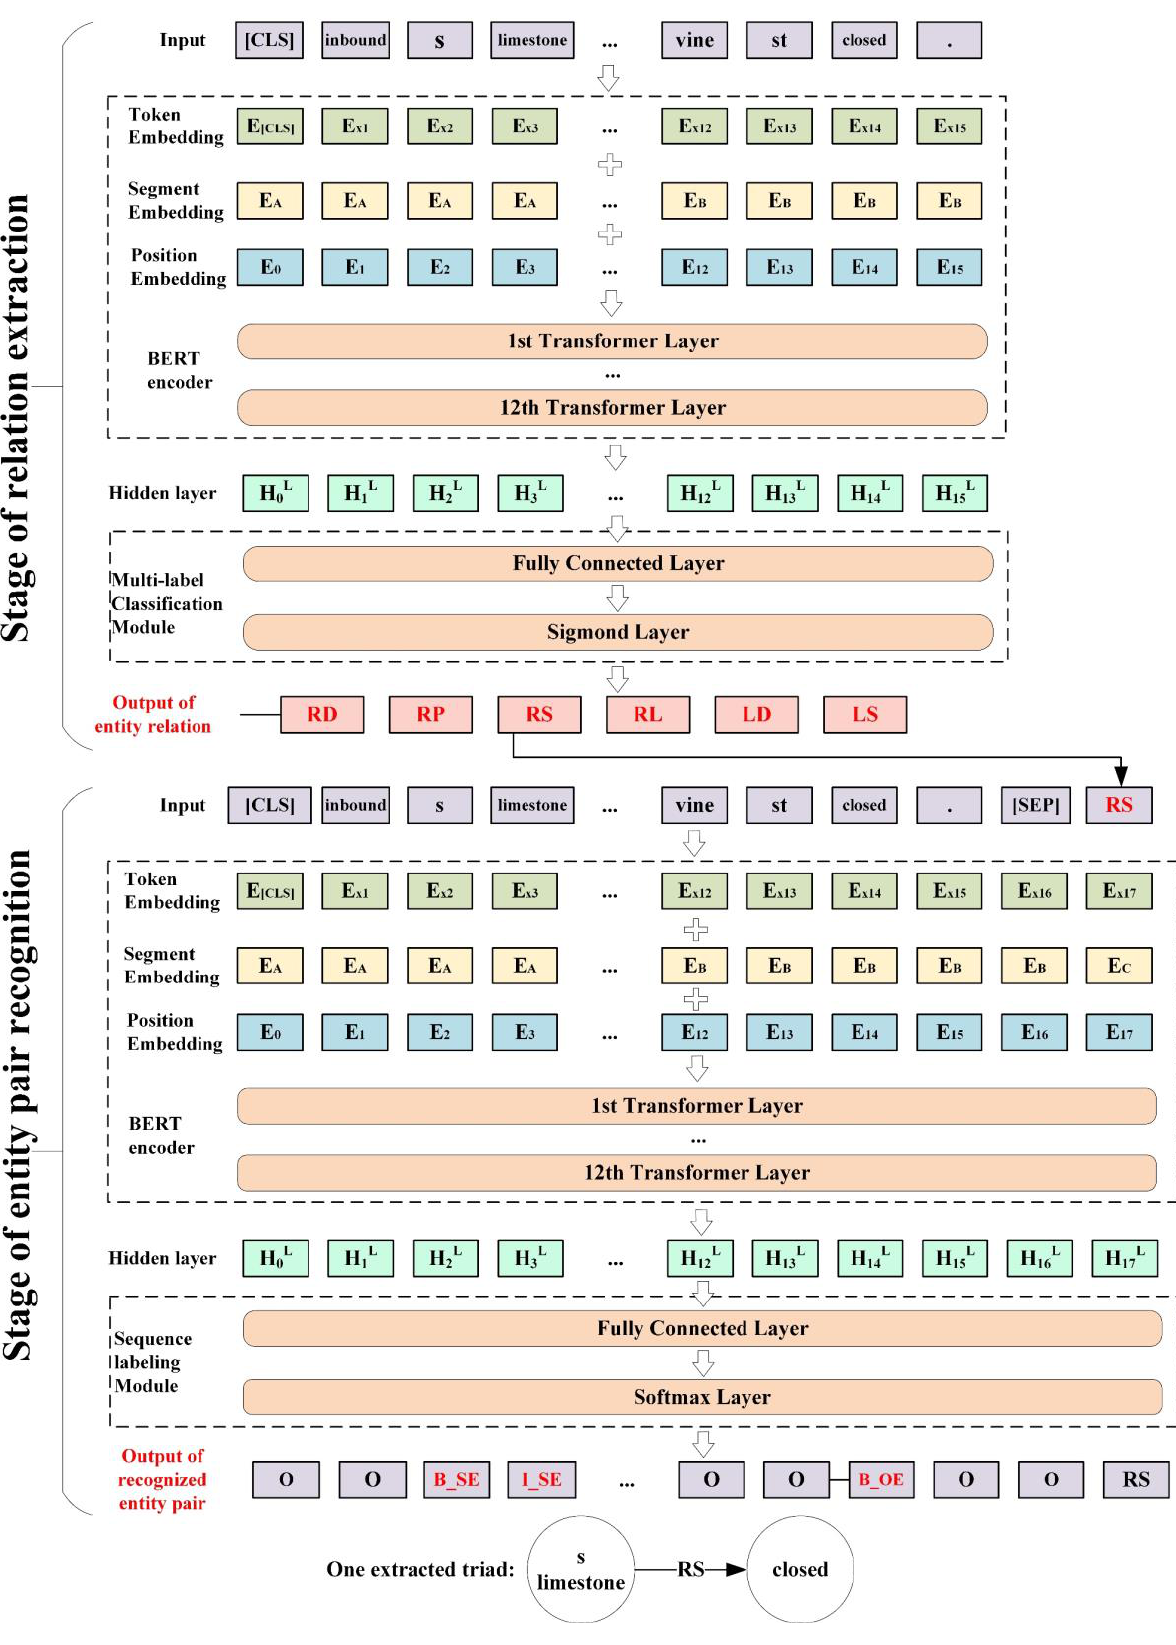
Figure 4. Joint relation extraction and entity recognition model developed in the SMDbS.